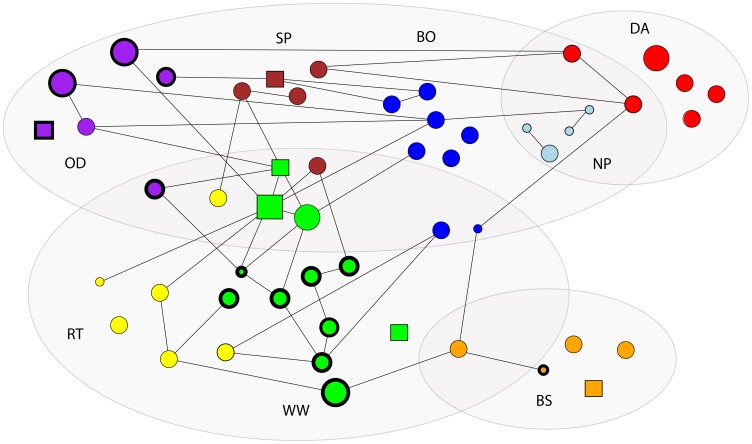
The genetic ties among adults.The shape specifies sex: circle = female and square = male. Thick borders indicate natal animals. Color indicates group. The size of the squares and circles refers to generation: large = first, midsized = second, and small = third generation. Shaded areas are genetic clusters of animals.